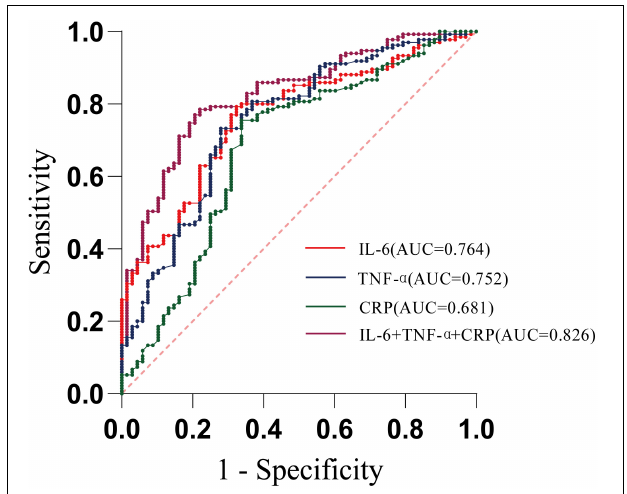
FIGURE 2 | Receiver operating characteristic curve analysis predicting depression using circulating inflammatory cytokines. ( AUC —area under curve; dotted line—reference